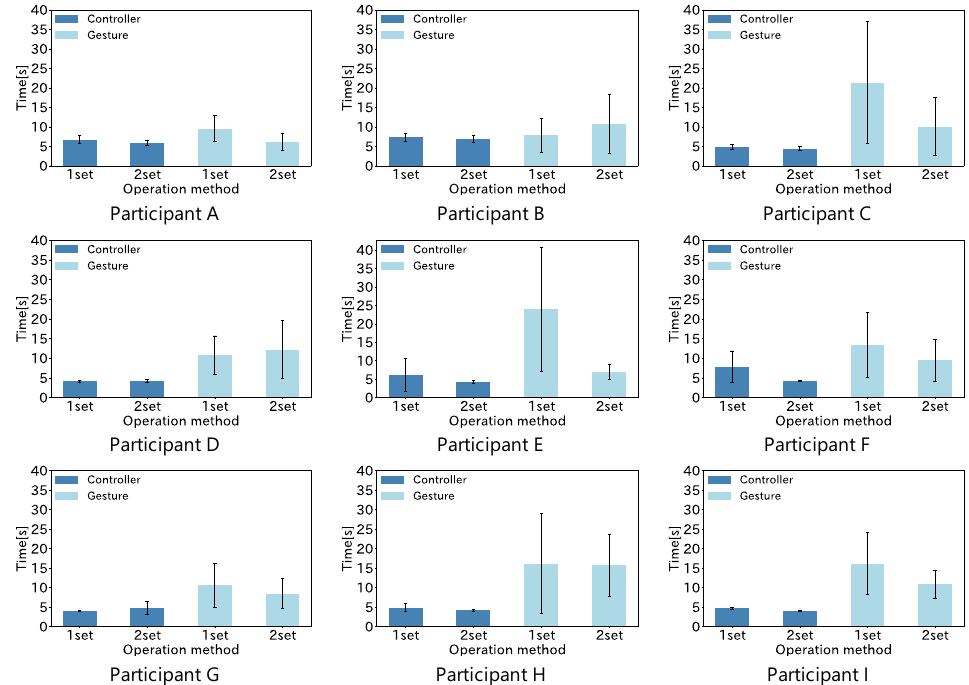
Figure 16. Task completion results for each operation method.